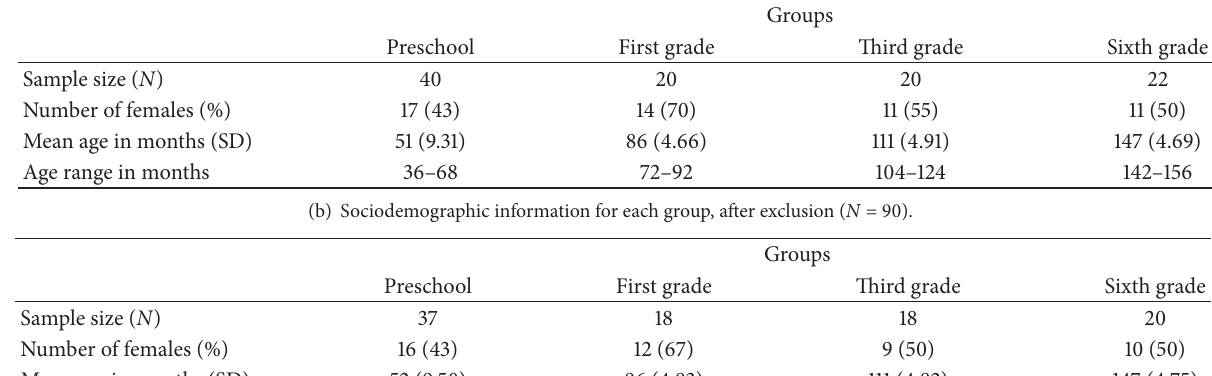
Table 1: Sociodemographic information for each group. (a) Sociodemographic information for each group, before exclusion ( N =